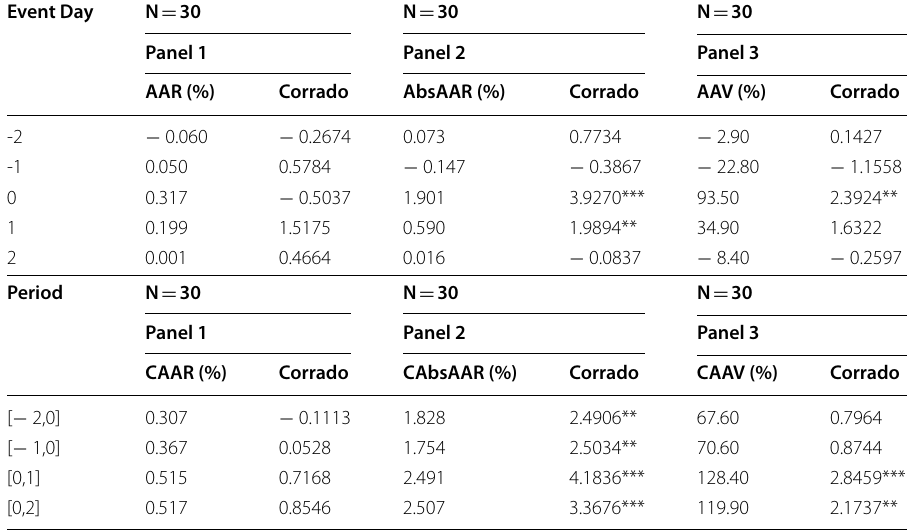
Table 2 This table summarizes the AAR, CAAR, AbsAAR, CAbsAAR, AAV and CAAV on and around the date of the announcement of Pfizer’s COVID‑19 vaccine for the companies listed on the DJIA index. Results obtained using factor returns from